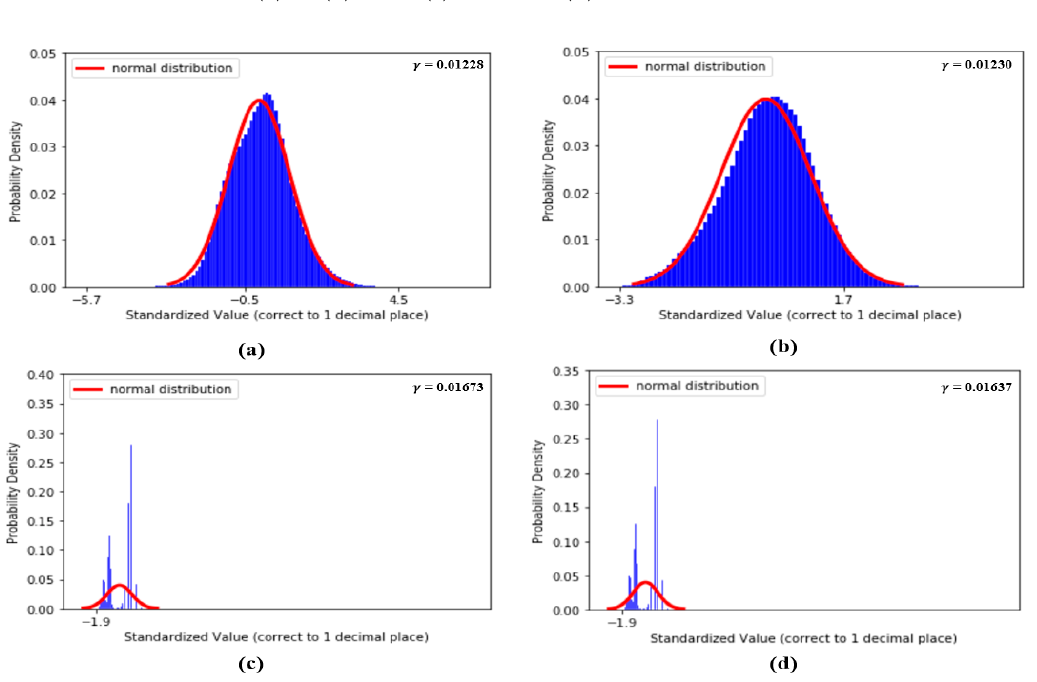
Figure 8. Distribution of normalized notch intensity.